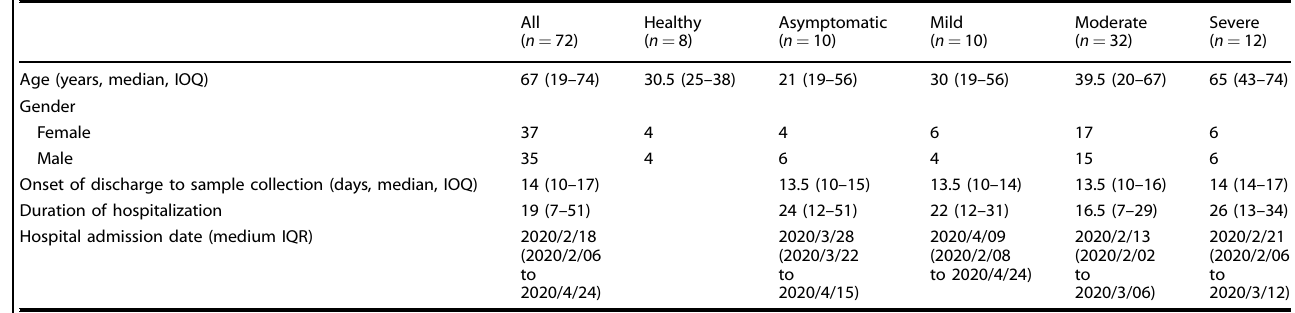
Table 1. Characteristics of patients in this study